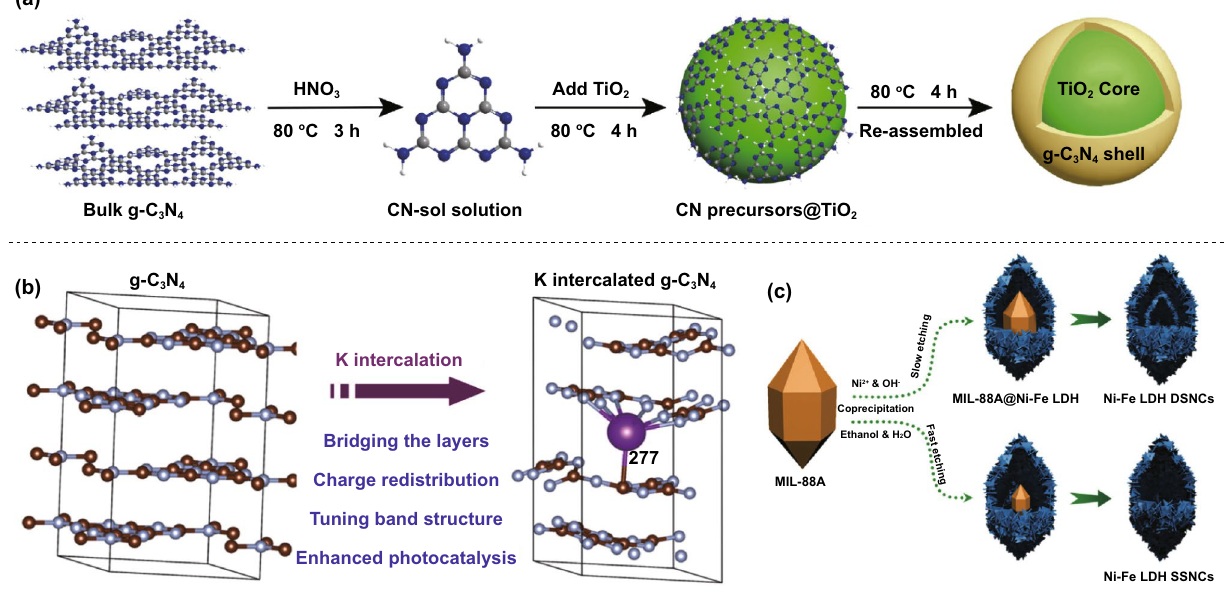
Fig. 2 Strategies for catalytic activity enhancement. a Core–shell structures of g-C 3 N 4 @TiO 2 promote carrier separation. Reproduced with per- mission [121]. Copyright 2018, Elsevier. b K-doped g-C 3 N 4 nanomaterials to achieve enhanced visible-light absorption, efficient carrier separa- tion and strong oxidation capability. Reproduced with permission [136]. Copyright 2016, American Chemical Society. c Ni–Fe LDH nanocages with regulated tunable shells perform optimal chemical composition possessing large electroactive surface area. Reproduced with